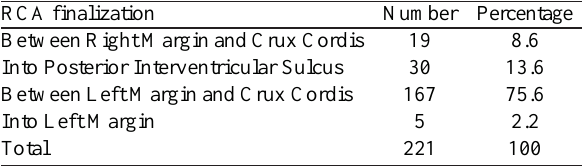
Table 1. Right coronary artery´s territory finalization.